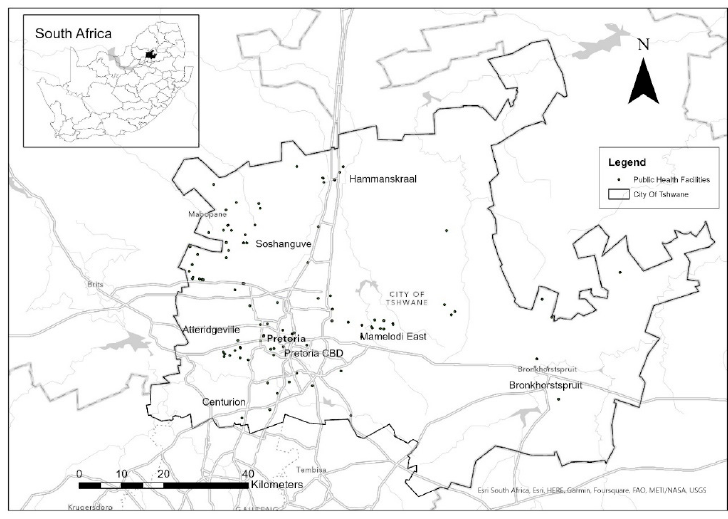
Figure 1. Study Area—City of Tshwane (Data source: Department of Health).